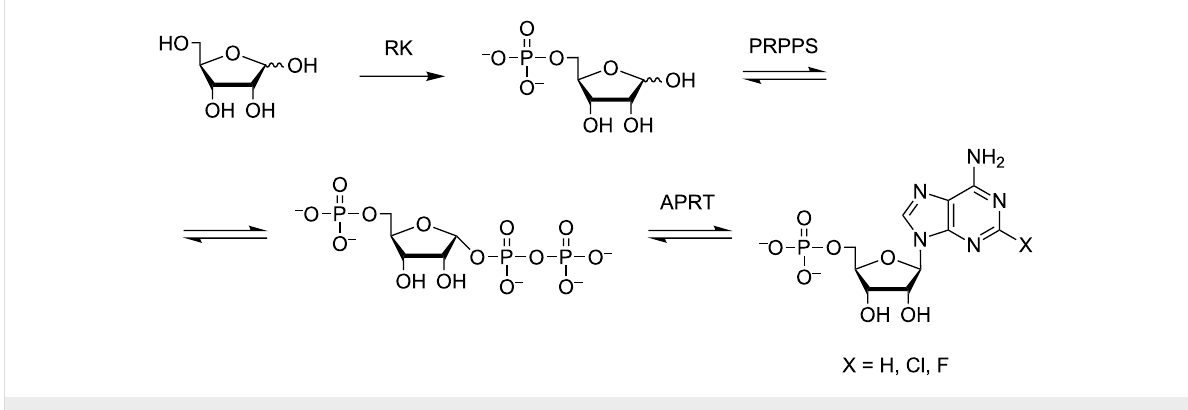
Figure 1: A multi-enzymatic synthesis of modified adenosine -5'-monophosphates.